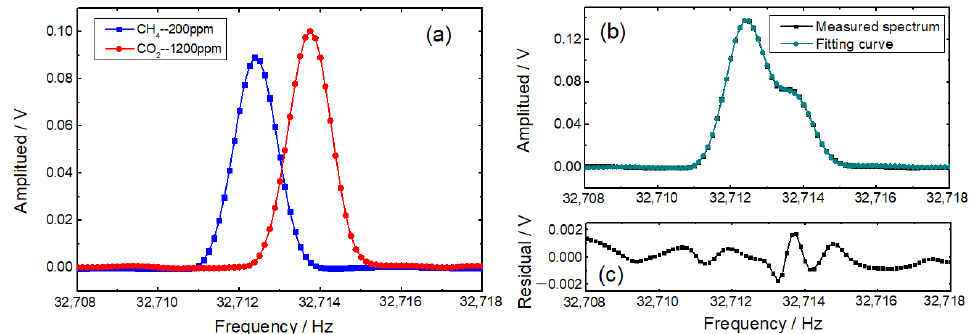
Figure 6. ( a ) Frequency-domain 2 f signals of 200 ppm CH 4 and 1200 ppm CO 2 ; ( b ) a demonstration of multiple linear regression with the gas mixture of 300 ppm CH 4 and 800 ppm CO 2 ; ( c ) fitting residuals.